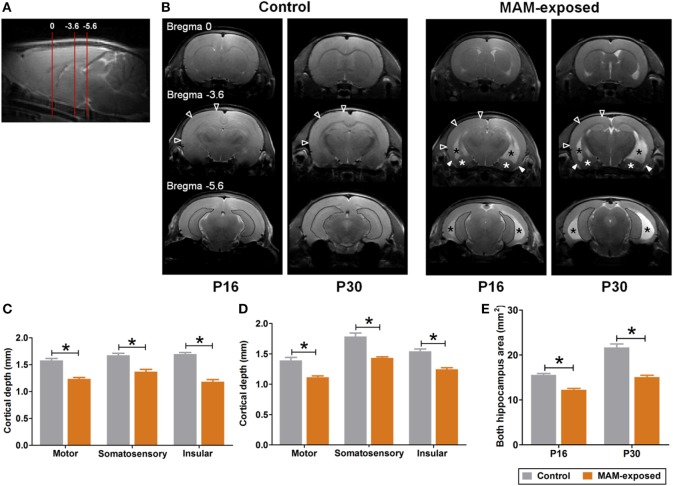
Representative T2-weighted magnetic resonance images and comparisons of cortical depth and hippocampal size between prenatally methylazoxymethanol acetate (MAM)-exposed rats and controls on postnatal day (P) 16 and P30. (A) Relative magnetic image locations (red lines) where cortical depth (3.5 mm posterior from the bregma) and hippocampal size (5.6 mm posterior from the bregma) were measured. (B) Compared to controls, MAM-exposed rats showed significant thinning of entorhinal cortex (filled arrowheads) and enlarged ventricles (black asterisks). Volume reduction and dysplasia were observed in both hippocampi (dotted area) and amygdala (white asterisks) of MAM-exposed rats at P16 and P30. To determine regional changes in cortical thickness, the depths of the motor, somatosensory, and insular cortices in one coronal section (empty arrowheads at bregma, −3.6 mm AP) were measured on P16 (C) and P30 (D). Compared to controls (n = 4), the mean depths of motor (p = 0.016 at P16, p = 0.016 at P30), somatosensory (p = 0.016 at P16, p = 0.016 at P30), and insular (p = 0.016 at P16, p = 0.016 at P30) cortices were significantly decreased in MAM-exposed rats (n = 5). (E) A significant reduction in the mean area of both hippocampi (dotted area at the bregma, −5.6 mm) was also observed in MAM-exposed rats on P16 (p = 0.016) and P30 (p = 0.016). Values expressed as mean ± SEM. *p < 0.05 using the Mann–Whitney U test for comparison between the groups.